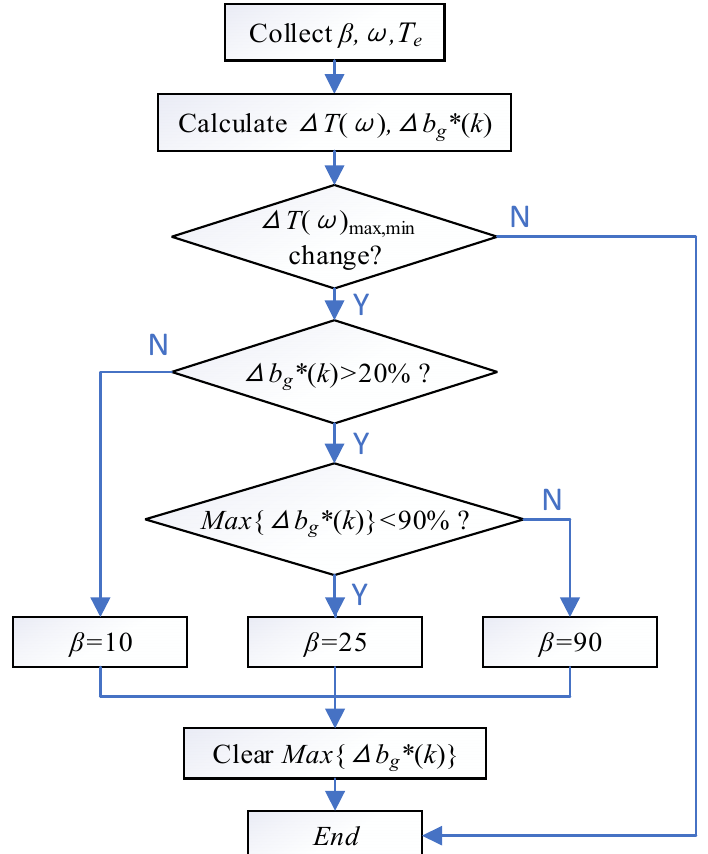
Figure 6. Work flow chart of the error gain factor module.